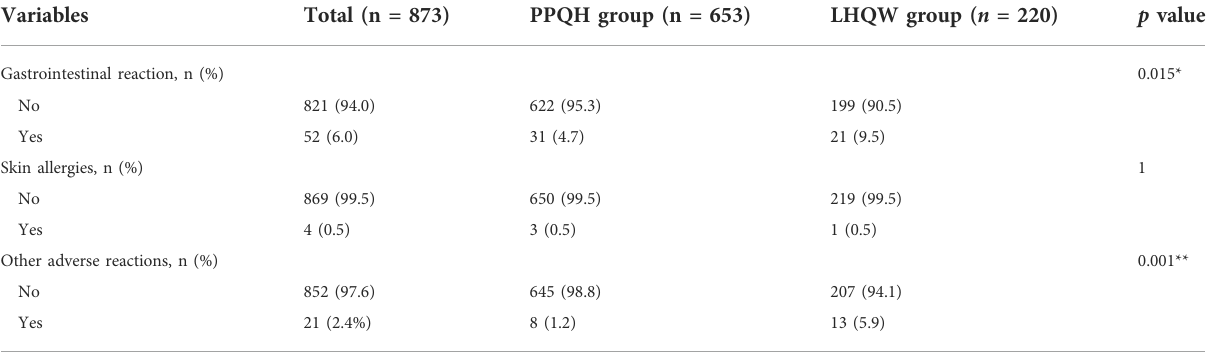
TABLE 10 Comparison of the adverse reaction rates between the two groups of SARS-CoV-2-infected patients. Variables Total (n = 873) PPQH group (n = 653) Gastrointestinal reaction, n